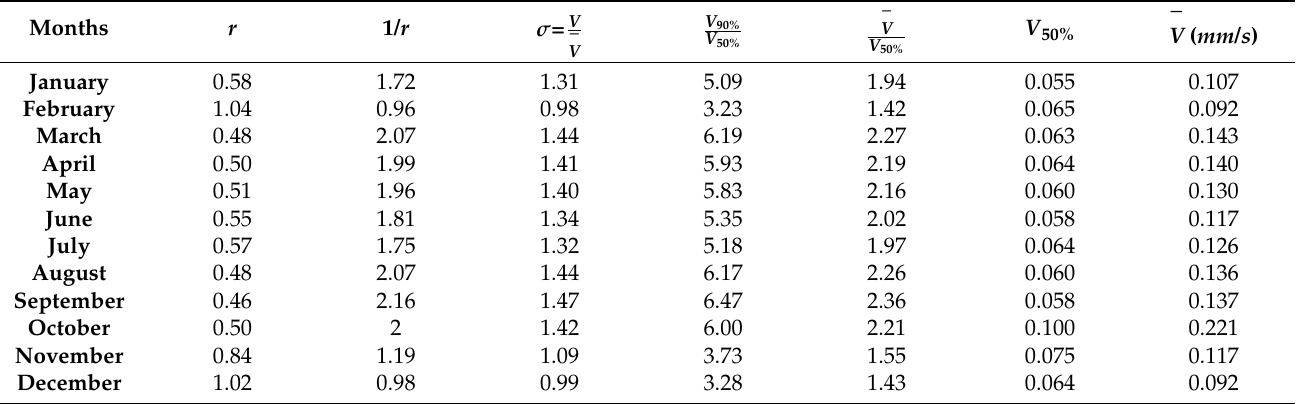
Table 4. Mean settling velocity of suspended solids as a function of the shape parameter r charac- teristic of the Lobo reservoir in 2020.